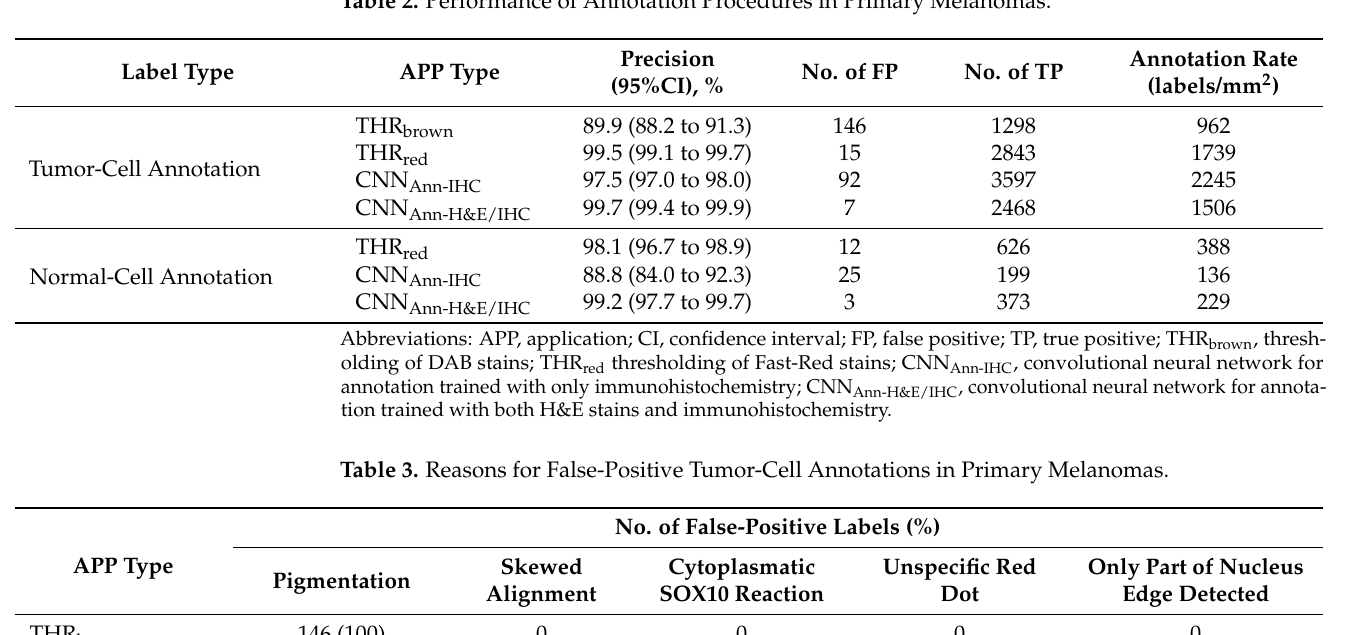
Table 2. Performance of Annotation Procedures in Primary Melanomas.